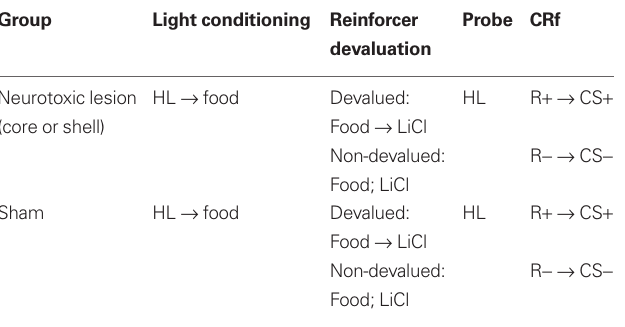
Table 1 | Outline of experimental procedures.